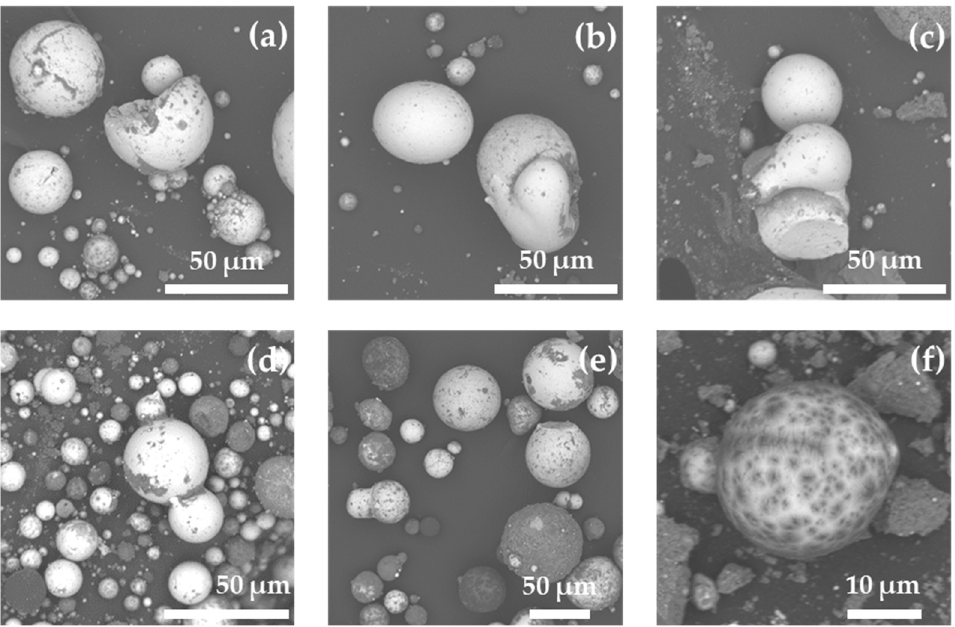
Figure 8. SEM images showing typical particle defects: ( a ) agglomerates, gas entrapments and cracks, ( b ) particle fusion, ( c ) dents, splats, platelets, ( d ) satellites and particle fusion, ( e ) particle collision and fusion, strong surface contamination, ( f ) dendritic structure (+brittle graphite frag- ments).